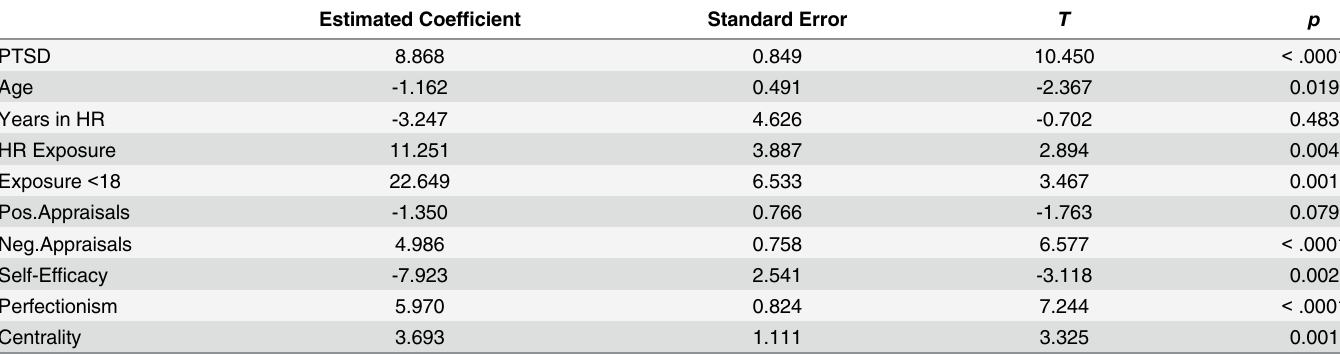
Table 5. Simple linear regression models predicting depression.